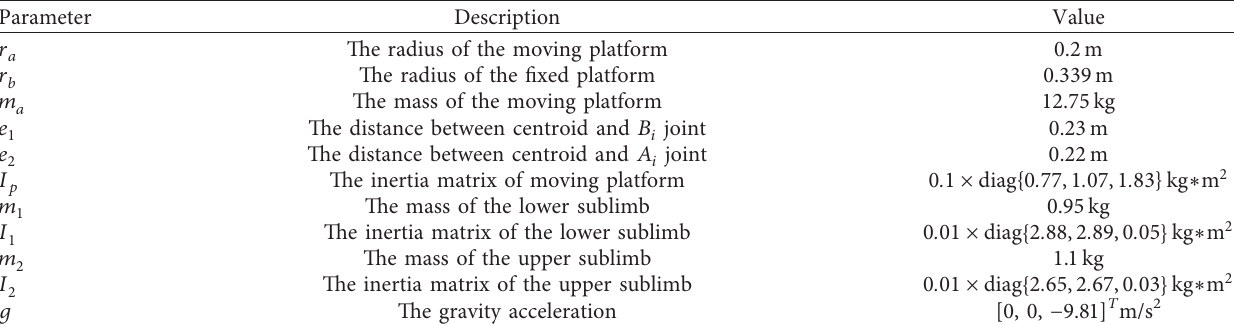
Table 1: Structural parameters of the parallel manipulator.